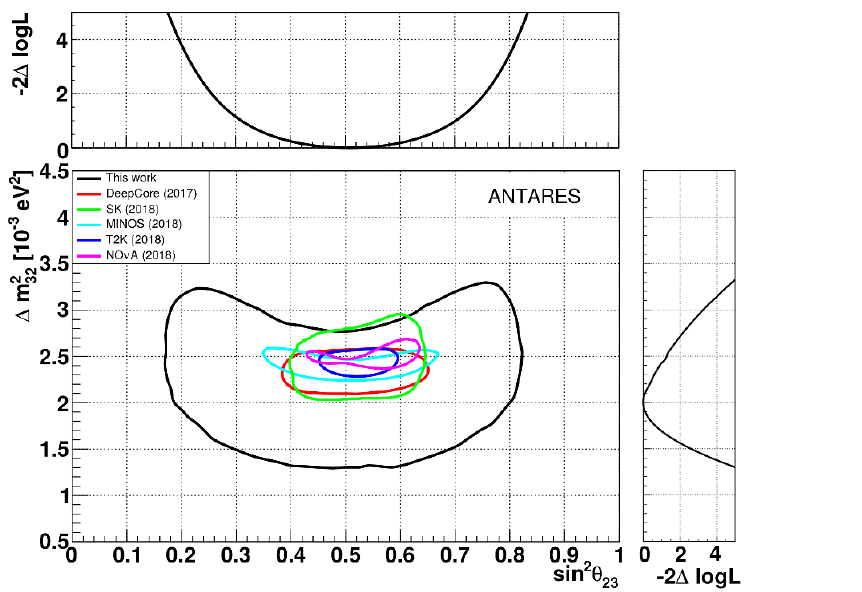
obtained in this work (black 32